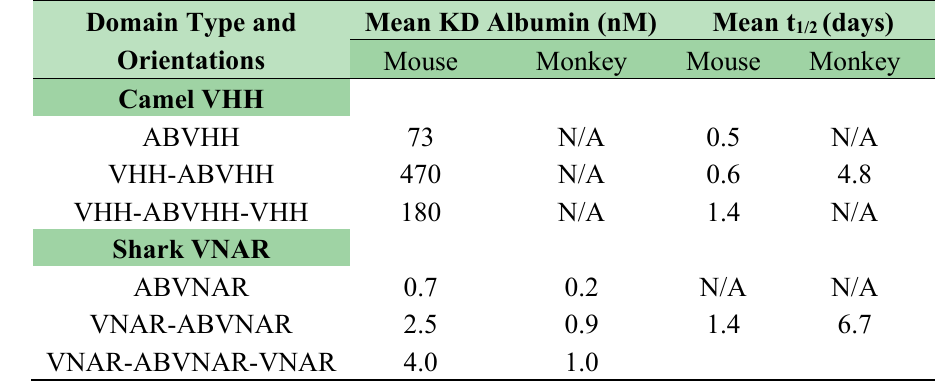
extension (after a single i.v. administration) of fusion proteins consisting at their core of albumin binding domains derived from either camel or